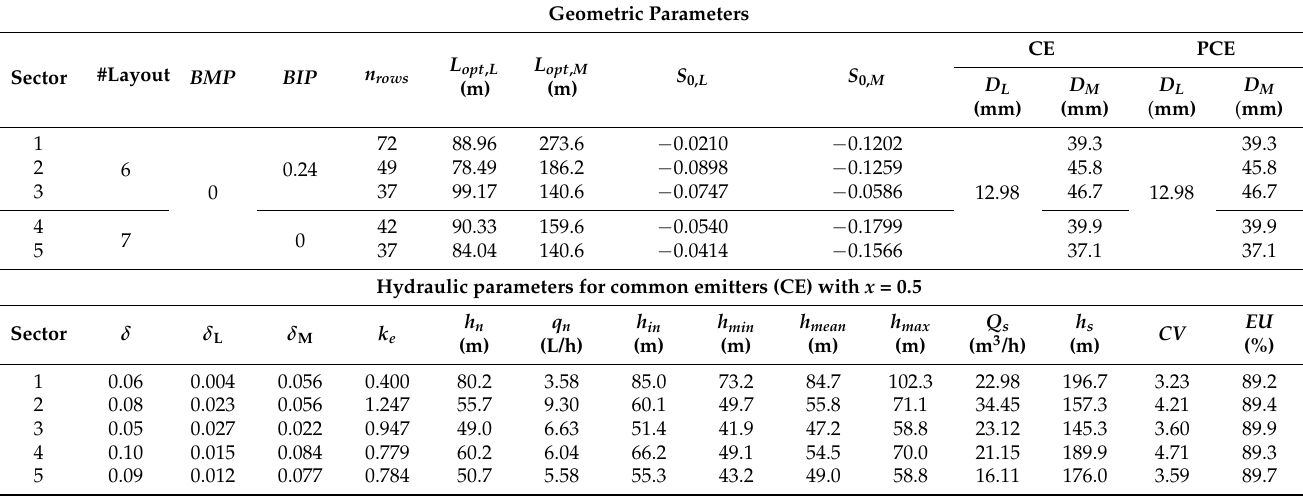
Table 4. Geometric and hydraulic design parameters for the actual “non-uniform” five sectors of the apple farm designed by IRRILAB, for common emitters (CE) and pressure compensating emitters